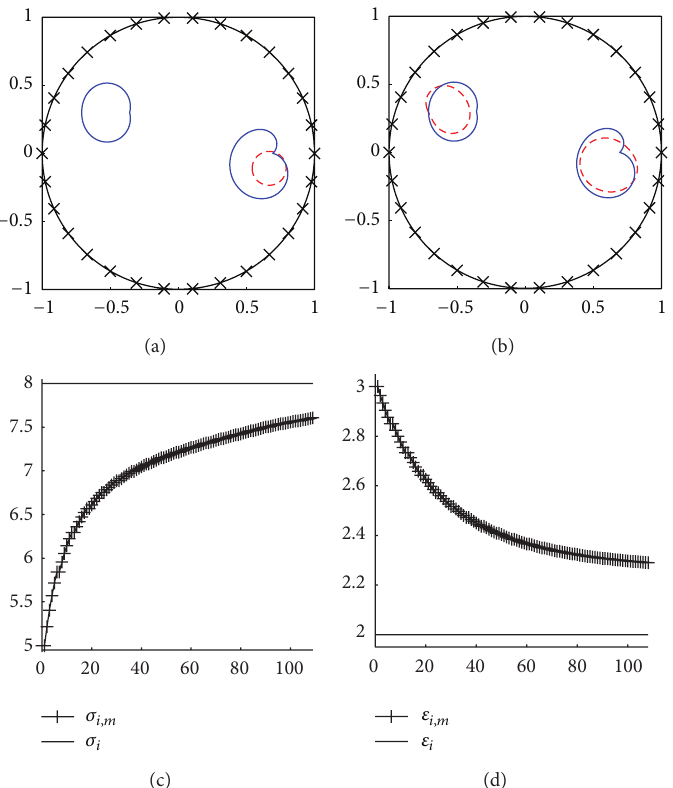
Figure 12: Reconstruction of objects by impedance tomography. (a) Initial guess. (b) Final reconstruction of the objects after 17 updates with respect to the domain. (c) Convergence of the conductivity. (d) Convergence of the